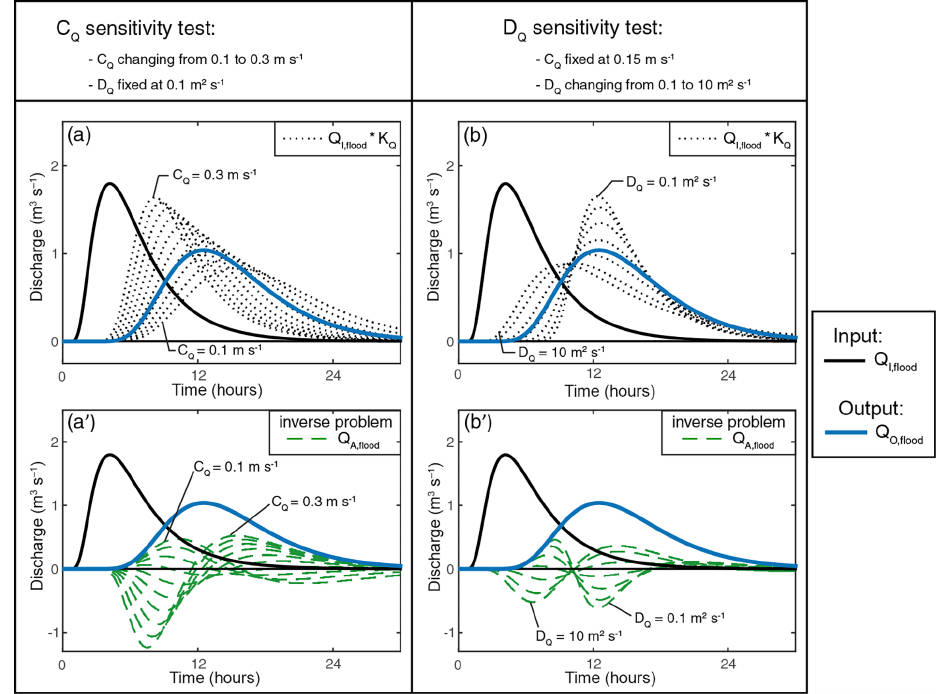
Figure 5. Sensitivity analysis of the model parametrization. Graphs (a–b) illustrate the simulation of the routed input Q I , routed (dashed black lines) without lateral exchange, while graphs (a’ ) and (b’) illustrate the inverse problem approach which simulate lateral flows Q A, flood (dashed green lines). Graphs (a–a’) and (b–b’) correspond to sensitivity test of C Q and D Q ,